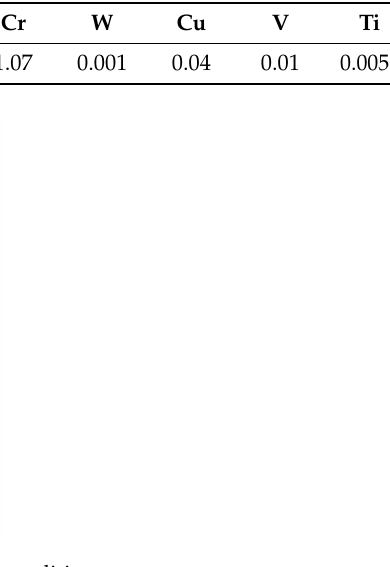
inner and outer surfaces of the specimens were polished. We ensured that the collet of the were blocked with metal